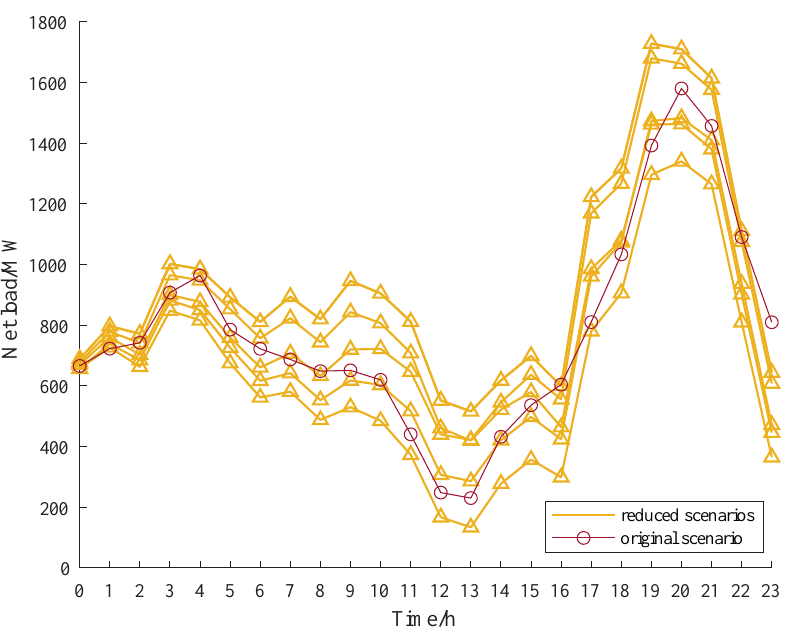
Figure 10. Results of proposed approach .